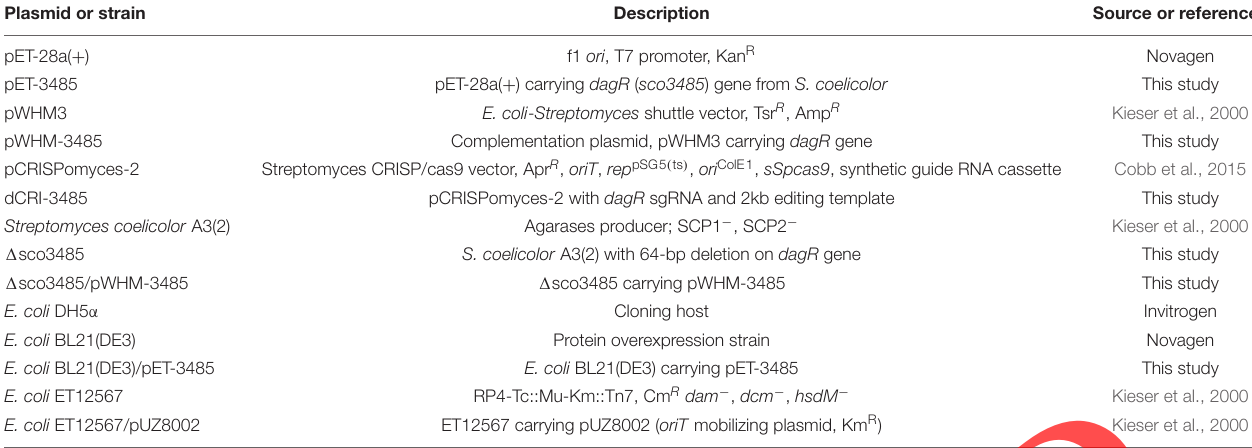
TABLE 1 | Bacterial strains and plasmids used in this